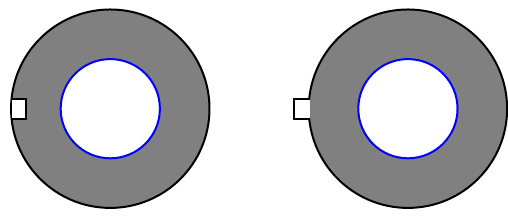
Figure 10 . Bipartition of the constant time slice. Left and right panels are equivalent.